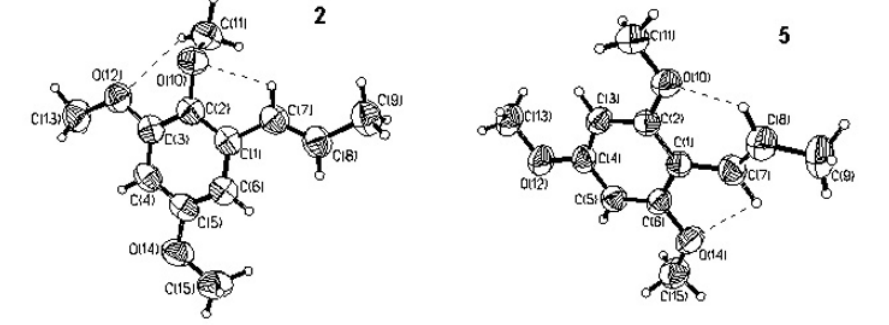
Figure 2. X-ray structures of compounds (2) and (5), showing interactions between the side chain and methoxy group [